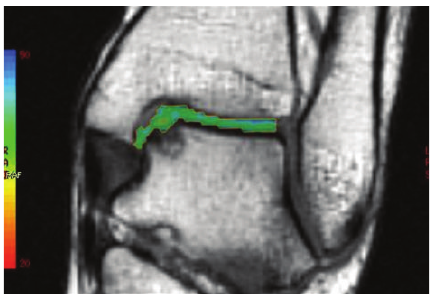
Figure 4: The T2 mapping MRI performed one year after the second treatment shows a 42msec value, a sign of hyaline cartilage